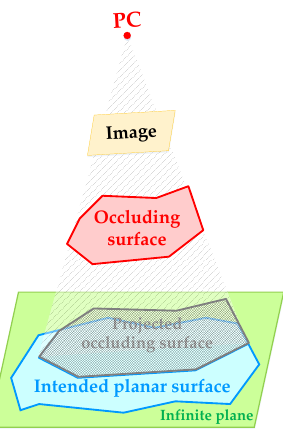
Figure 11. Identification and omission of the occluded part of the intended planar surface—occluding by another planar surface.